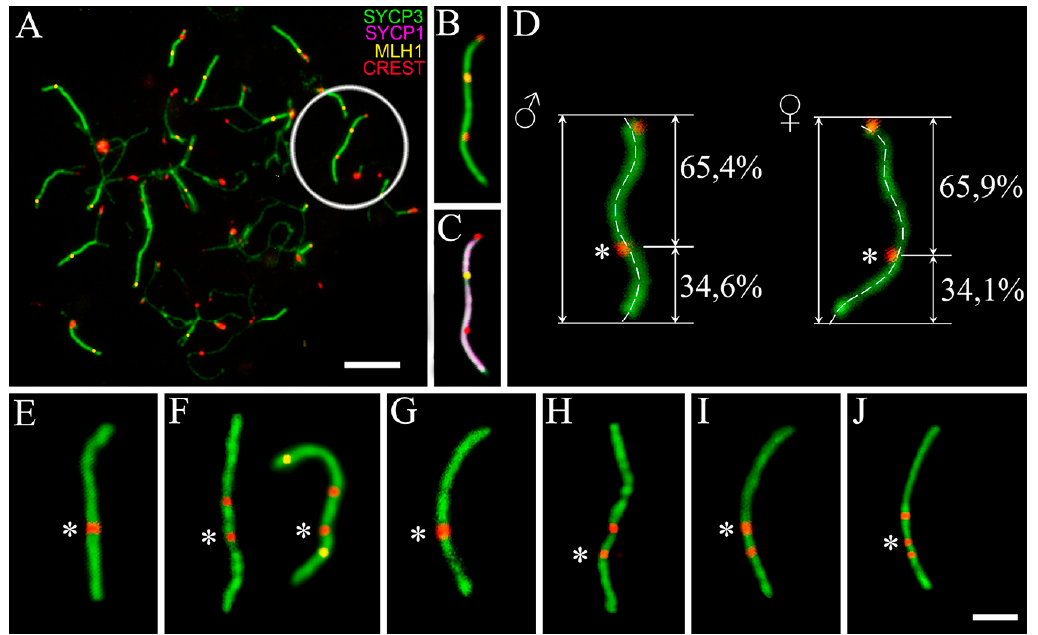
Figure 1. Variations of a centromere position in the submetacentric chromosome in the early meiotic prophase I of mole voles. Axial elements were identified using anti-SYCP3 antibodies (green), central element usinganti-SYCP1 (magenta), recombination nodules usinganti-MLH1 (yellow), and anti-CREST for kinetochores (red). The asterisk shows the location of the centromeric signal of the submetacentric homolog (33–35% of the telomere end). The red signal without asterisk marked erratic centromere positions in the submetacentric. ( A ) spermatocytes from interspecific hybrids F1 of Ellobius talpinus (2n = 54) × Ellobius tancrei (2n = 34). Bar = 5 µ m. A submetacentric is in the circle (inset ( B – C )); ( D ) heteromorphic bivalent in females and males of the interspecific hybrid of mole voles. One centromeric signal originated from the acrocentric homologue of E. talpinus , the other from the submetacentric homologue of E. tancrei . A submetacentric chromosome from karyotypes of E. tancrei 2n = 54, male ( E ); E. tancrei 2n = 34, female ( F ); E. tancrei , intraspecific hybrid 2n = 50, male ( G ) and female ( H ); E. tancrei , intraspecific hybrid, 2n = 49, male ( I ) and female ( J ). Bar ( E – J ) = 2 µ m.